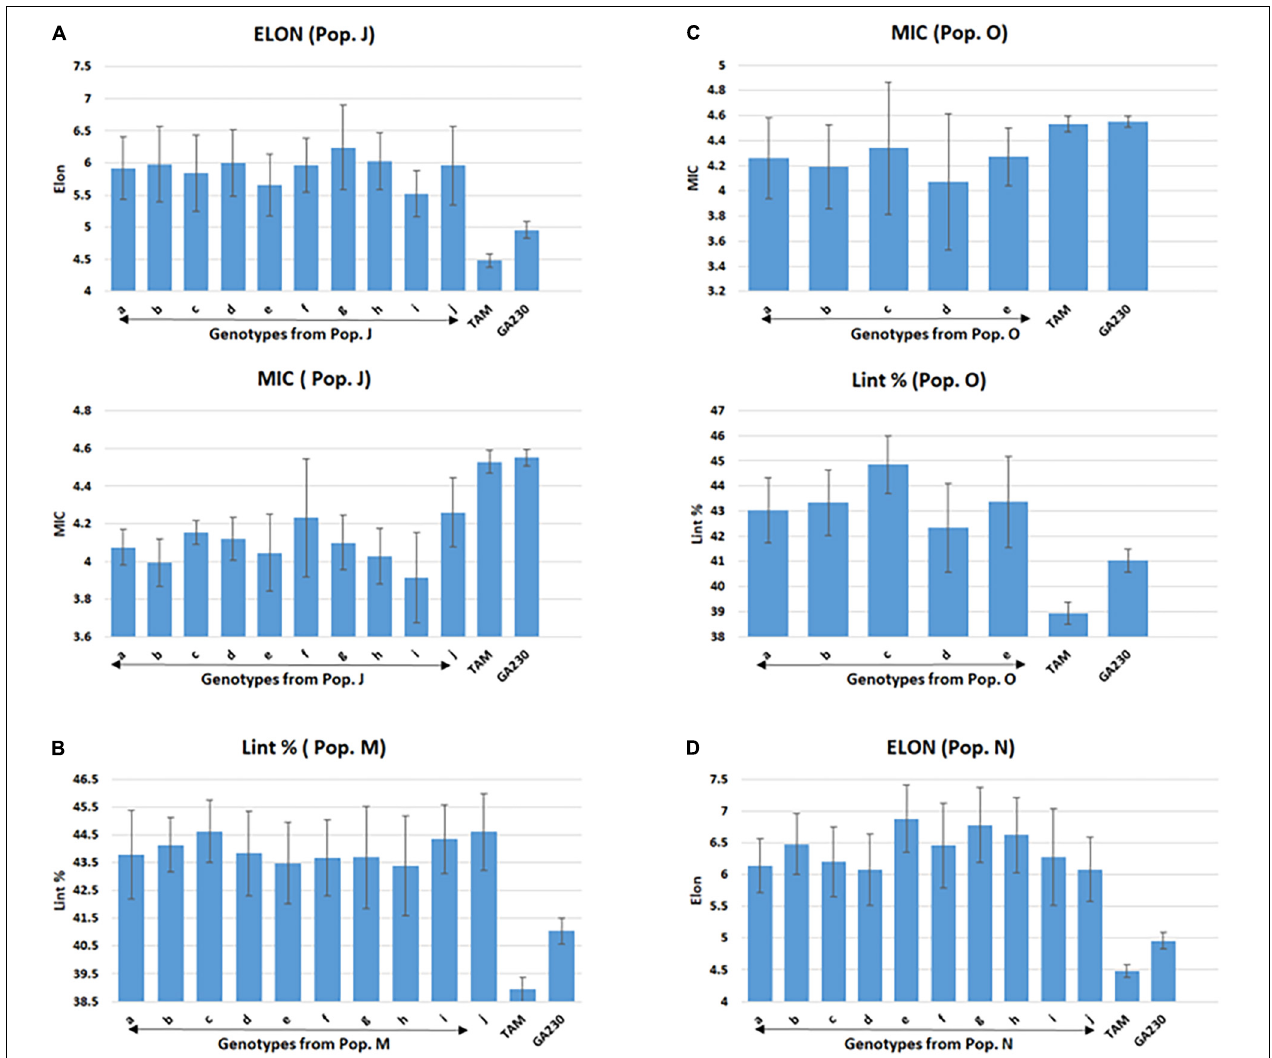
FIGURE 3 | Selected lines showing improvements over parental lines for targeted fiber trait in populations from TAM 94L25 (mutant) × GA230. (A) Population J (ELON and MIC), (B) population M (Lint %), (C) population O (MIC and Lint%), and (D) population N (ELON). Common letters on the x-axis of the graph indicate the same genotype of pops J (graphs A) and O (graphs C). Error bar indicates a standard error